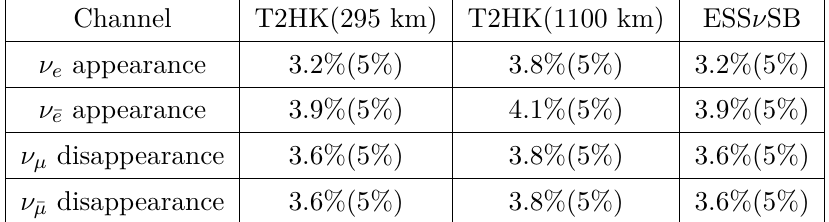
Table 2 . The signal(background) normalization uncertainties of the experiments for the various channels for T2HK, T2HKK and ESS ν